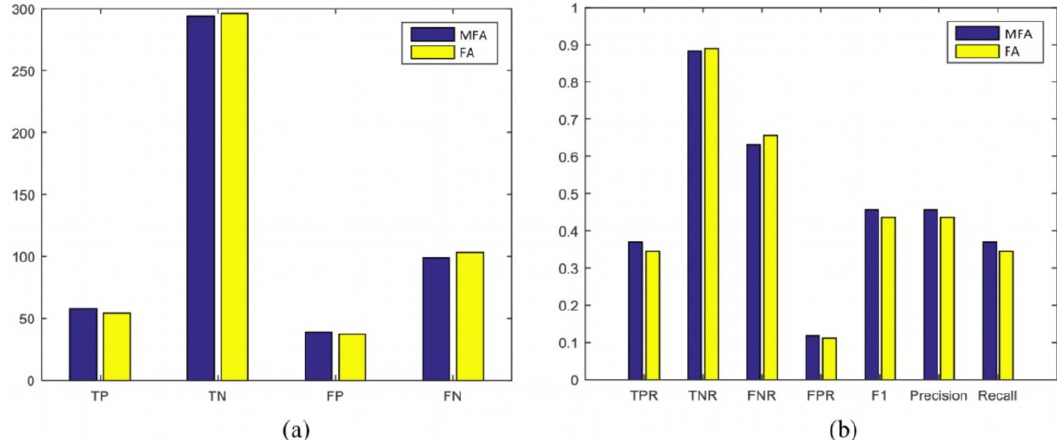
Figure 18. Scenario 3: Statistical evaluation of MFA-OSELM and FA-OSELM using two sets of measures, ( a , b ), for the TampereU dataset.